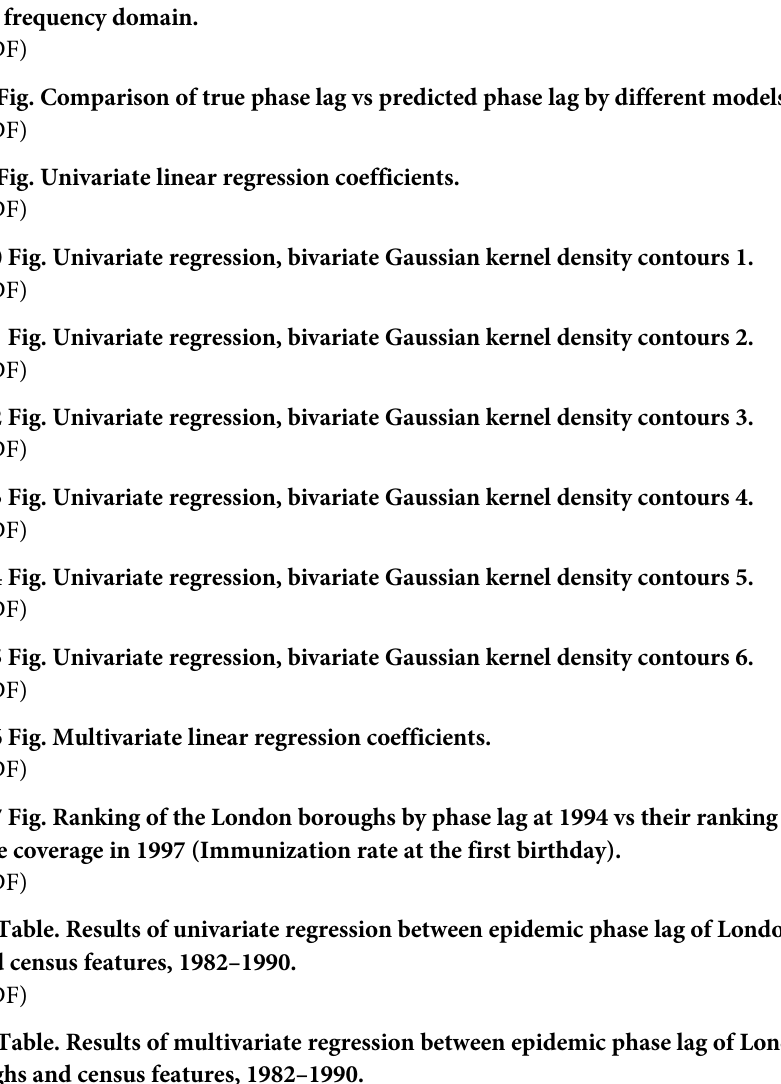
the frequency domain. (PDF) S8 Fig. Comparison of true phase lag vs predicted phase lag by different models. (PDF) S9 Fig. Univariate linear regression coefficients. (PDF) S10 Fig. Univariate regression, bivariate Gaussian kernel density contours 1. (PDF) S11 Fig. Univariate regression, bivariate Gaussian kernel density contours 2. (PDF) S12 Fig. Univariate regression, bivariate Gaussian kernel density contours 3. (PDF) S13 Fig. Univariate regression, bivariate Gaussian kernel density contours 4. (PDF) S14 Fig. Univariate regression, bivariate Gaussian kernel density contours 5. (PDF) S15 Fig. Univariate regression, bivariate Gaussian kernel density contours 6. (PDF) S16 Fig. Multivariate linear regression coefficients. (PDF) S17 Fig. Ranking of the London boroughs by phase lag at 1994 vs their ranking by the vac- cine coverage in 1997 (Immunization rate at the first birthday). (PDF) S1 Table. Results of univariate regression between epidemic phase lag of London boroughs and census features, 1982–1990. S2 Table. Results of multivariate regression between epidemic phase lag of London bor- oughs and census features, 1982–1990. S3 Table. Results of univariate regression between epidemic phase lag of London boroughs and census features,